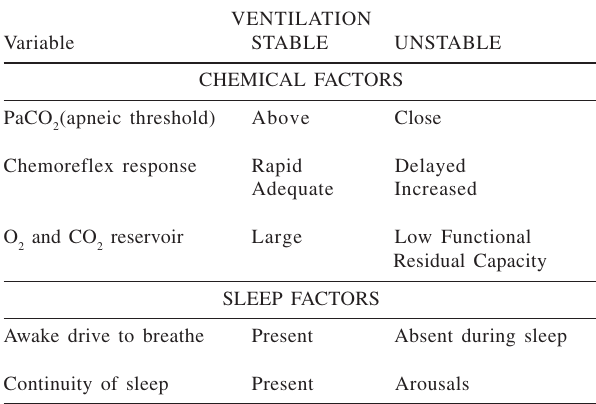
Table 1 - Mechanisms responsible for respiratory stability (STABLE) and instability (UNSTABLE) in congestive heart failure